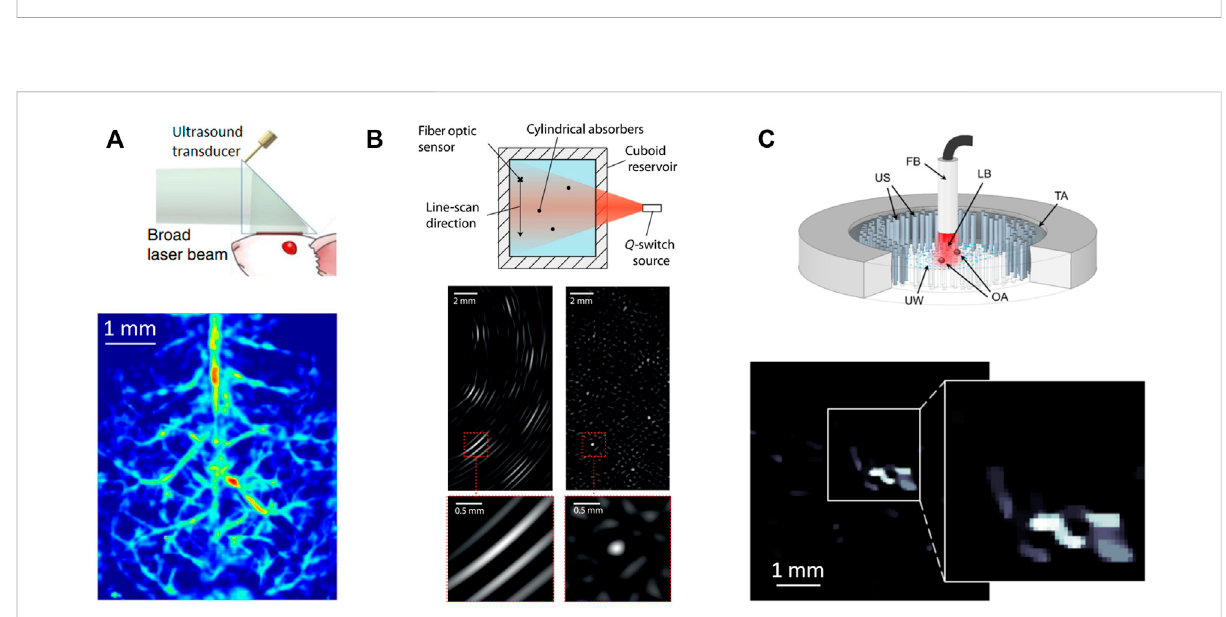
FIGURE 6 Model-based (MB) image reconstruction with time-resolved optoacoustic (OA) signals encoding the position of absorbers via complex propagation of ultrasound (US) waves. (A) Image of the cortical vasculature of the mouse brain obtained by exploiting US propagation through an ergodic relay. Adapted from [150] with permission from Nature Publishing Group. (B) Image of seven synthetic hairs sparsely distributed within an acoustically reverberant cavity causing multiple re fl ections of the US waves. Reprinted from [151] with permission from Optica Publishing Group. (C) Image of a zebra fi sh larva obtained by exploiting US transmission through a randomized scattering medium. Adapted from [71] with permission from American Physical